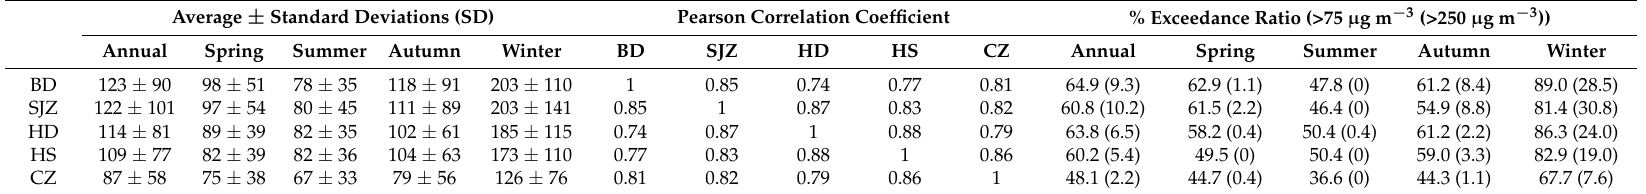
Table 1. Statistical summary of PM 2.5 in 5 cities during 2013–2015.